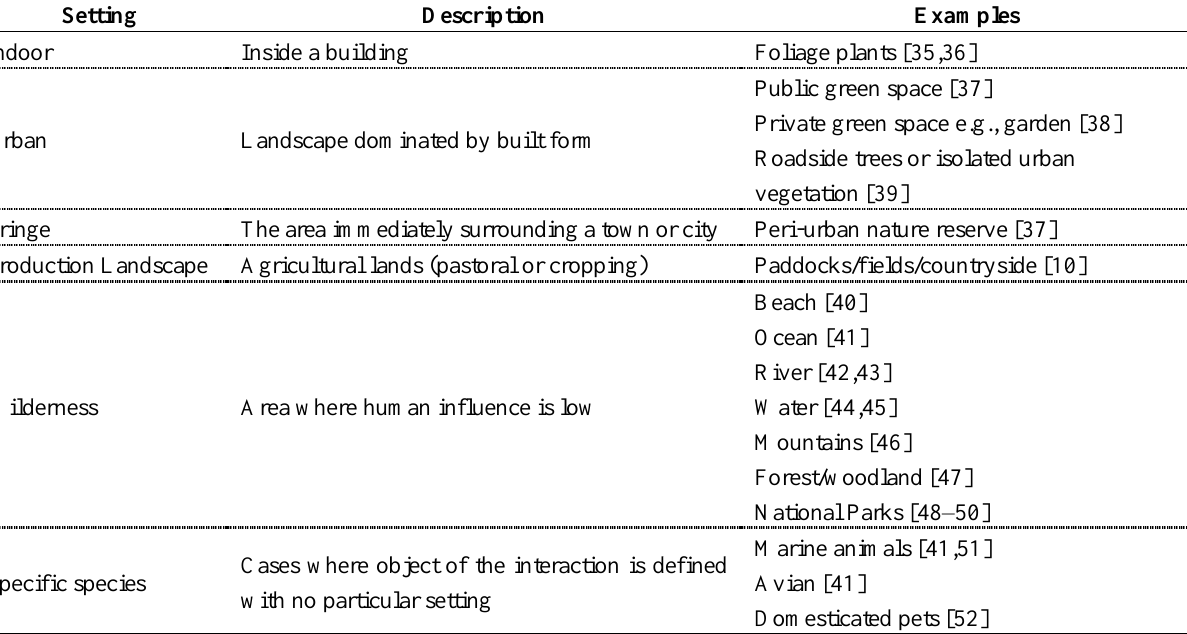
Table 1. Typology of settings in which interactions between people and nature